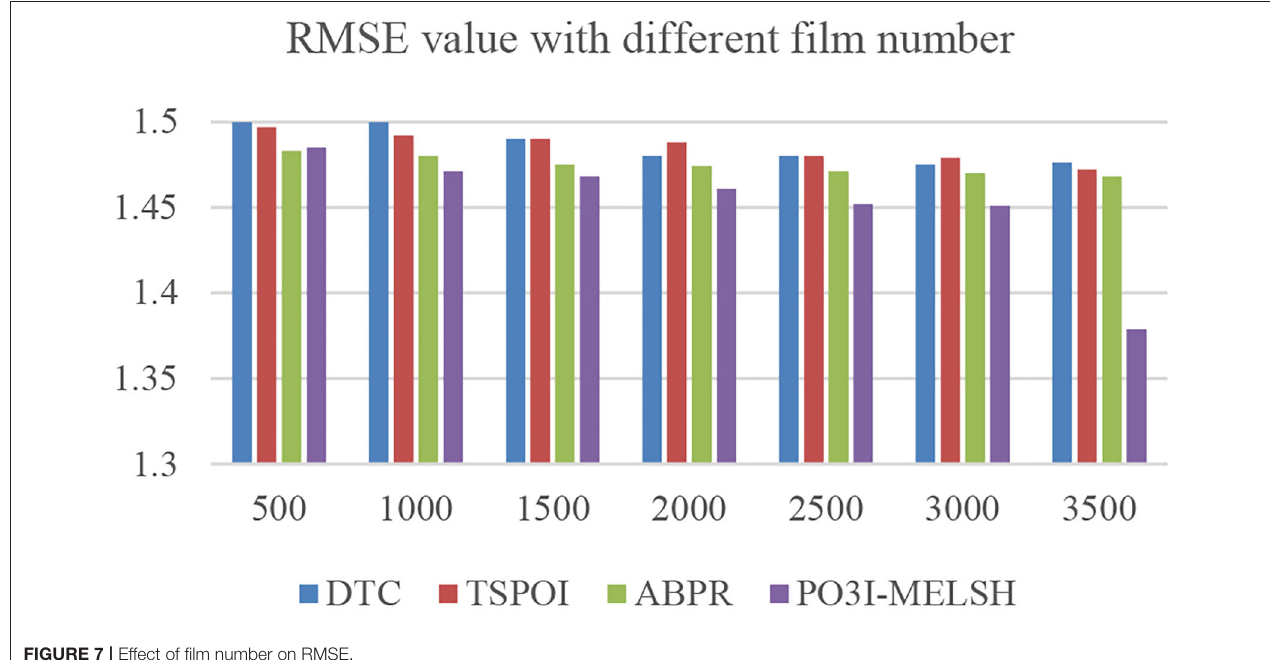
FIGURE 7 | Effect of film number on RMSE.